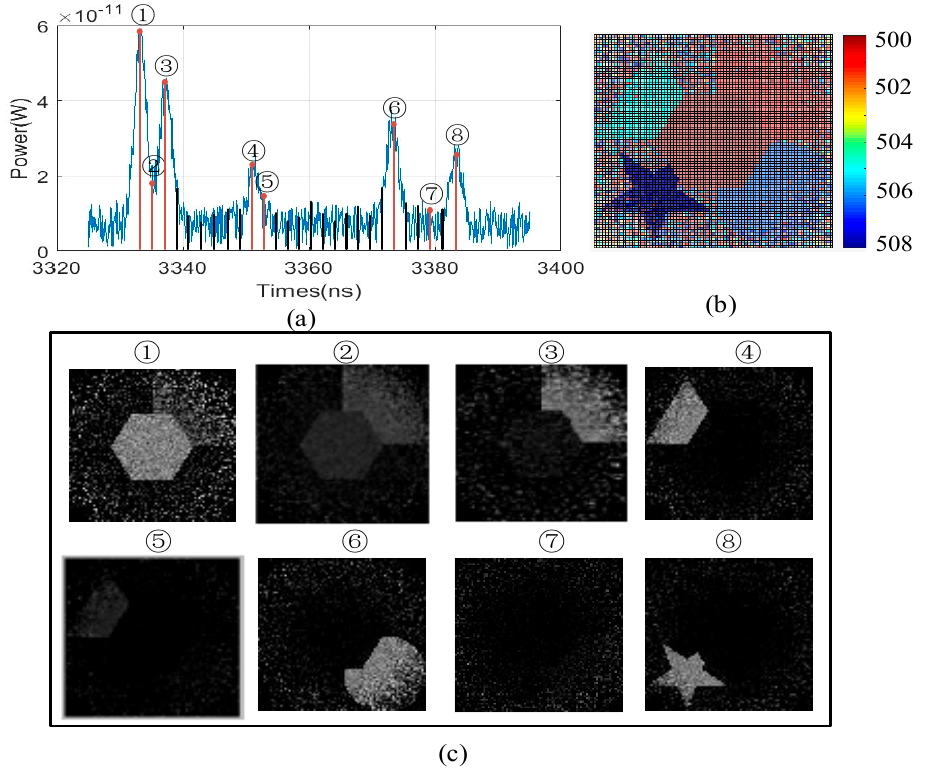
Figure 9. 3DGI and 2DGI based on UTSM: ( a ) Echo signal based on a single detector, ( b ) 3DGI via combining 2DGI, and ( c ) corresponding 2D images under different time slices in ( a ).